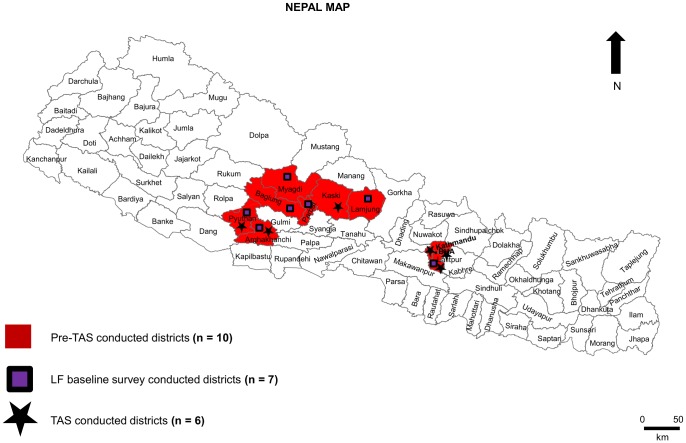
Map of Nepal showing the districts where the studies were conducted.Baseline survey was conducted in seven districts indicated by blue square, Pre-Transmission Assessment Survey was conducted in 10 districts indicated by red color and Transmission Assessment Survey was conducted in six districts indicated by star symbol.